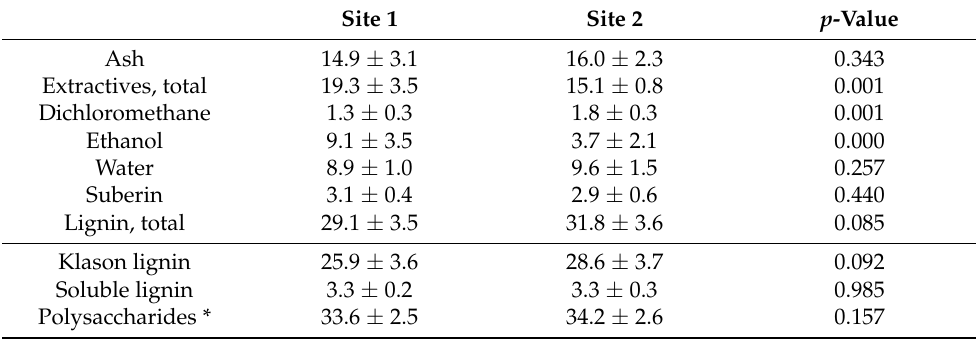
Table 2. Chemical composition (% of o.d. mass) of Quercus rotundifolia bark sampled at b.h. from two sites (mean of five trees and standard deviation). Site 1 Site 2 p -Value Ash